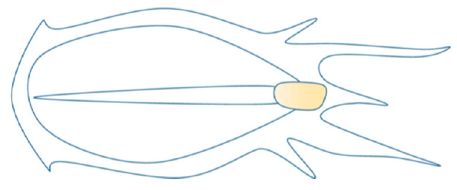
Figure 1. Illustration of individual salp animal [28].